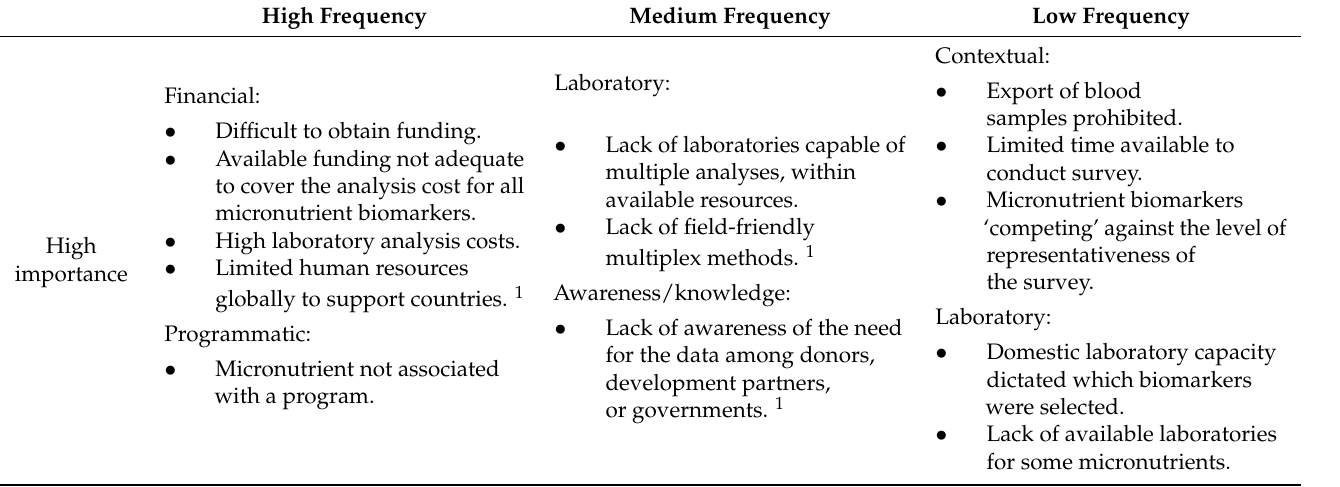
Table 3. Importance and frequency of reported barriers to inclusion of micronutrient biomarkers in national surveys and surveillance systems in six